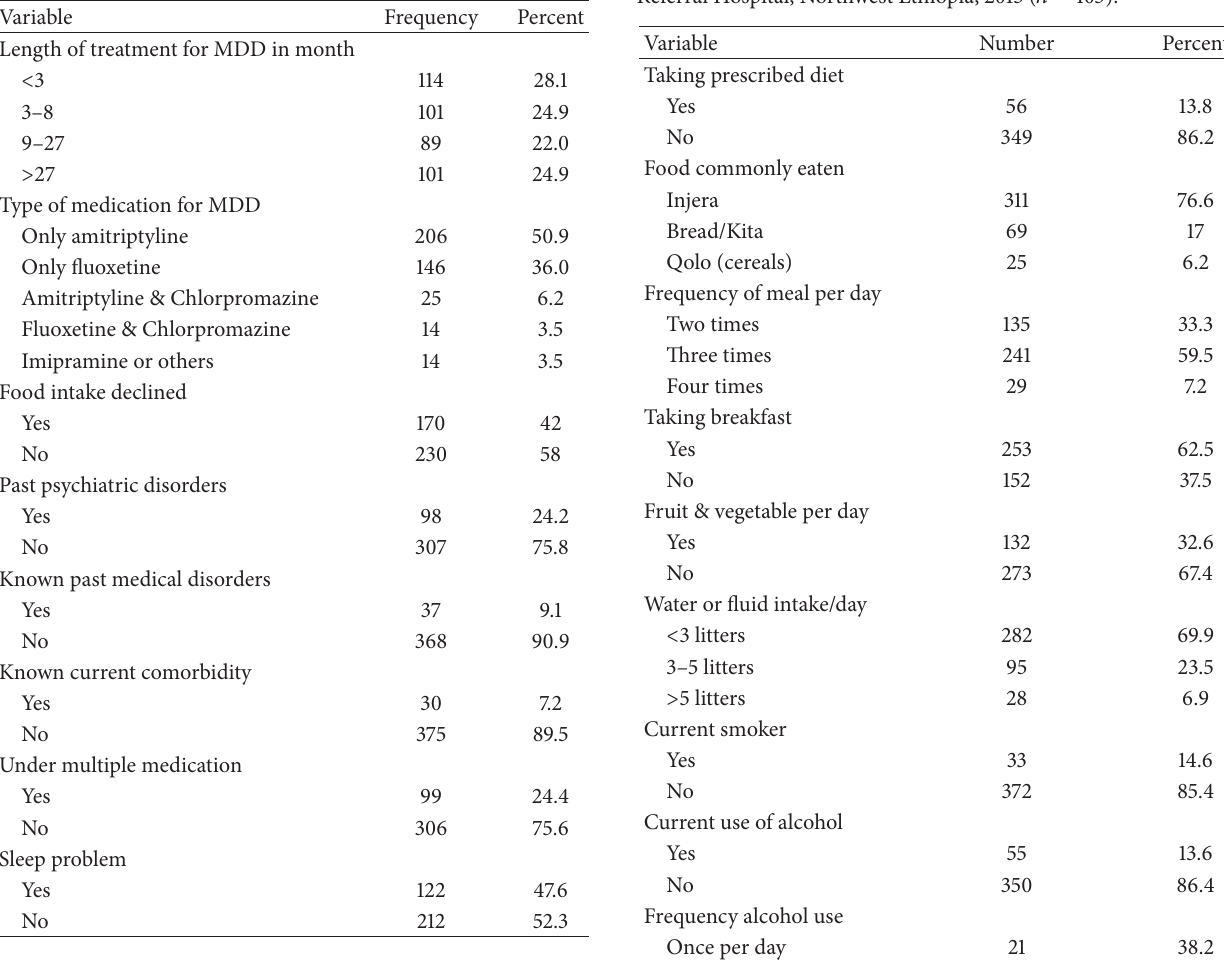
Table 2: Clinical characteristics of respondents with major depres- sivedisorderinUniversityofGondarReferralTeachingHospitaland Felege Hiwot Referral Hospital, Northwest Ethiopia, 2015 ( 𝑛 = 405 ).